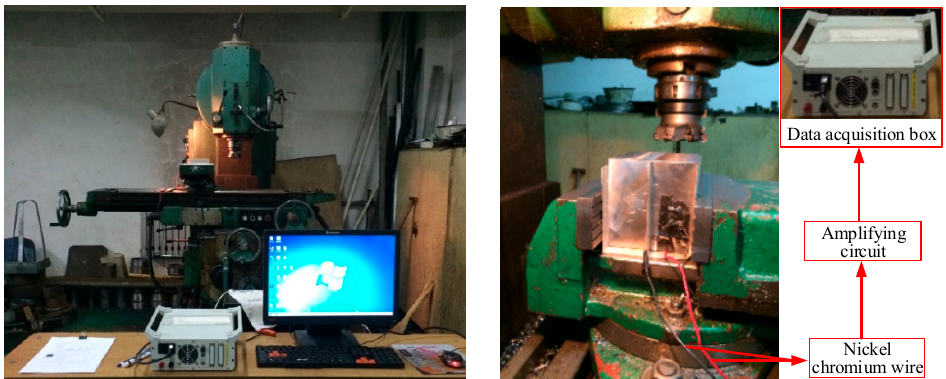
Figure 1. Field diagram of the milling temperature experiment.